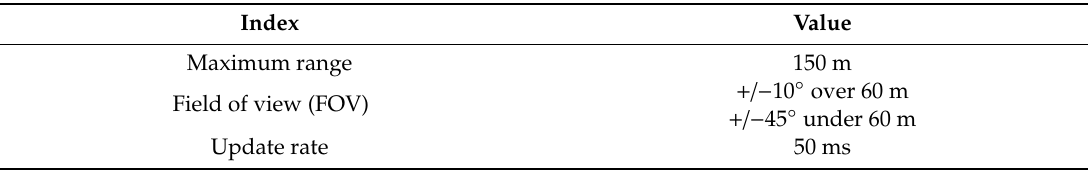
Table 7. Specifications of radar sensor.